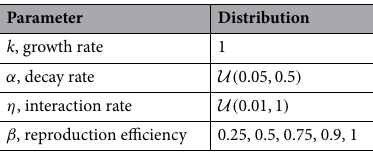
Table 1. Simulation parameters and their sample